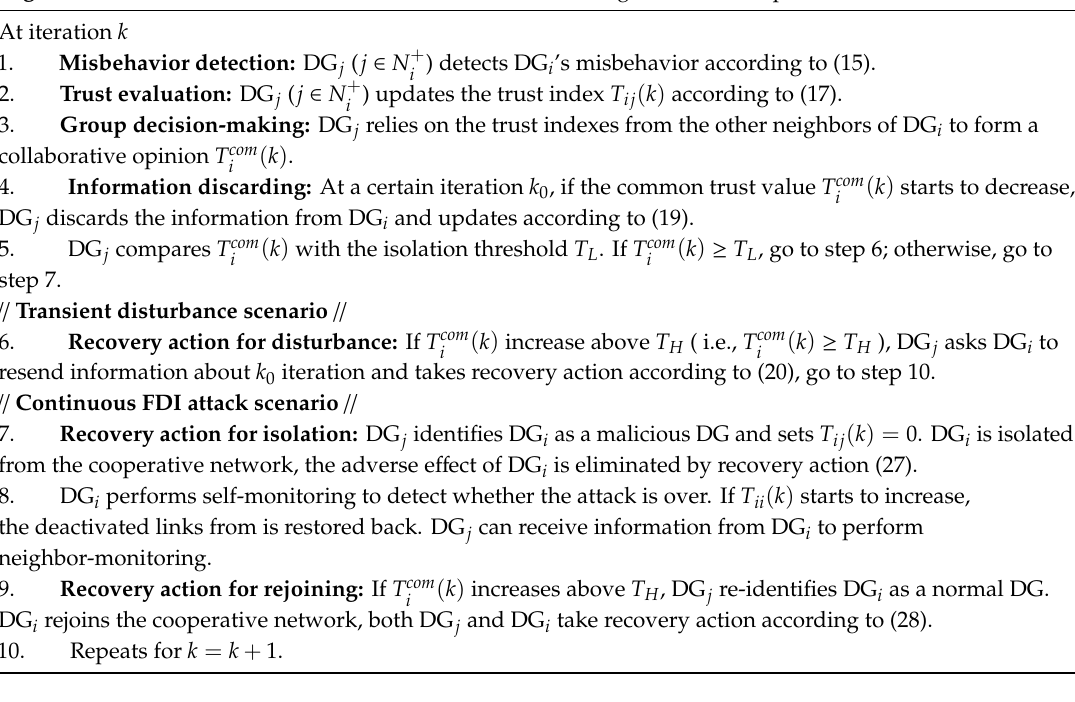
Algorithm 1. Trust-based resilient control framework for voltage and reactive power control.